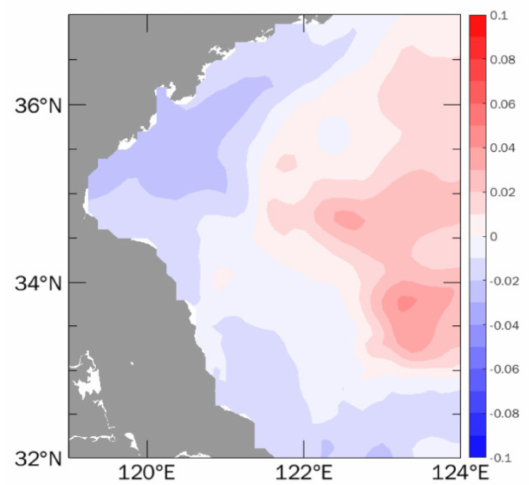
Figure 13. Sea level anomaly difference between Exp.curl and Exp.cw (unit: